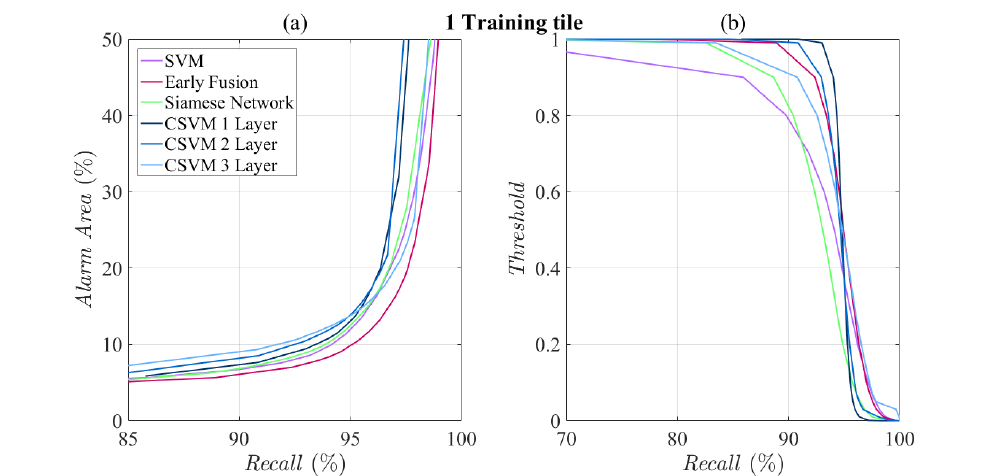
Figure 21. ( a ) Recall vs. Alarm Area (deforested area) for Cerrado biome using one training tile. ( b ) The recall values are obtained by threshold variation.